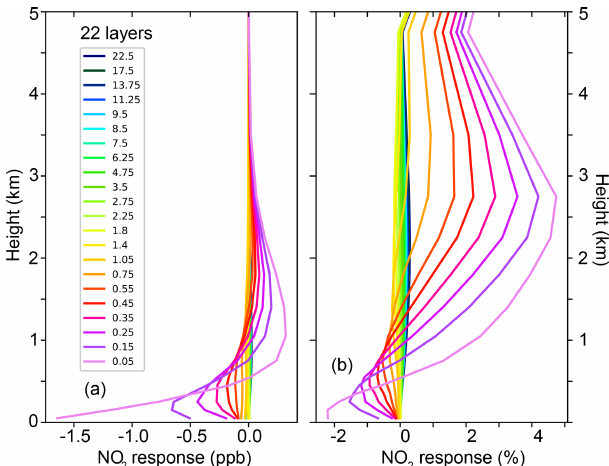
Figure 5. Plots showing the results of how sensitive the NO 2 profile is to changes in the aerosol extinction profile. (a) Columns of the matrix D created to describe the response in the NO 2 VMR profile (the differences with respect to the original retrieval). (b) Same as (a) but the response to the perturbation in the aerosol profile is given as a fraction of the retrieved NO 2